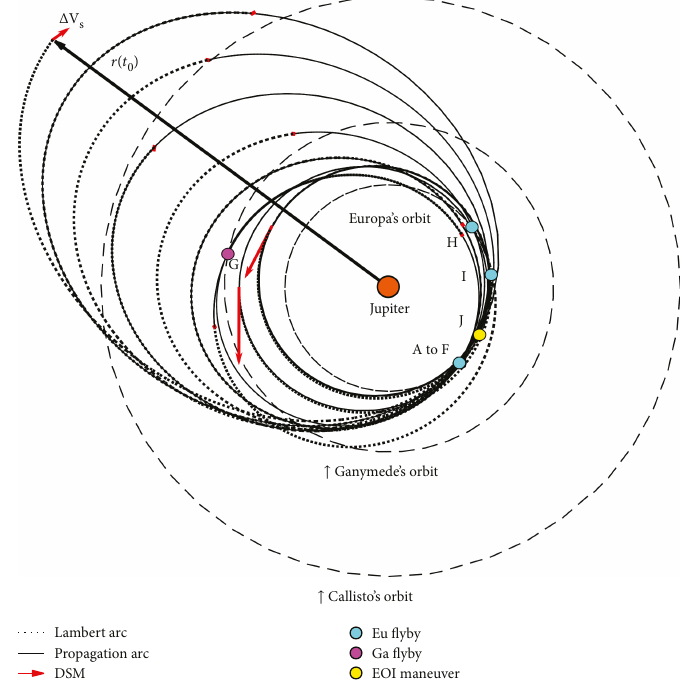
Figure 10: Jovicentric trajectory of solution C.